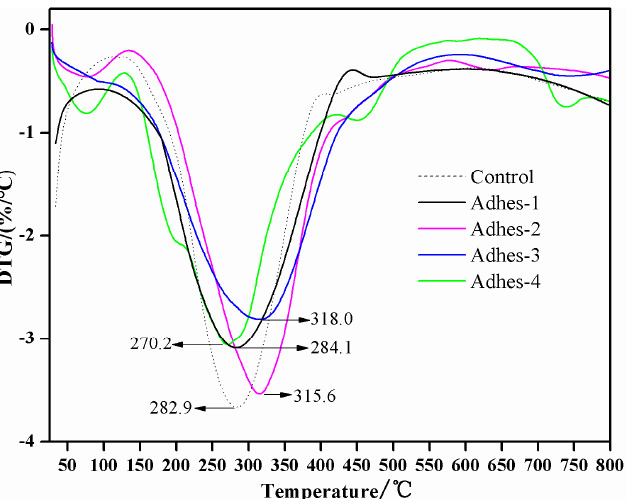
Figure 6. DTG results of Camellia oleifera cake-protein adhesives. Note: Control, pure Camellia oleif- era cake-protein hydrolysate; Adhes-1, the pure Camellia oleifera cake-protein adhesive, Adhes-2, Camellia oleifera cake-protein adhesive modified with DSP; Adhes-3, Camellia oleifera cake-protein adhesive modified with SPI; Adhes-4, Camellia oleifera cake-protein adhesive modified with casein.